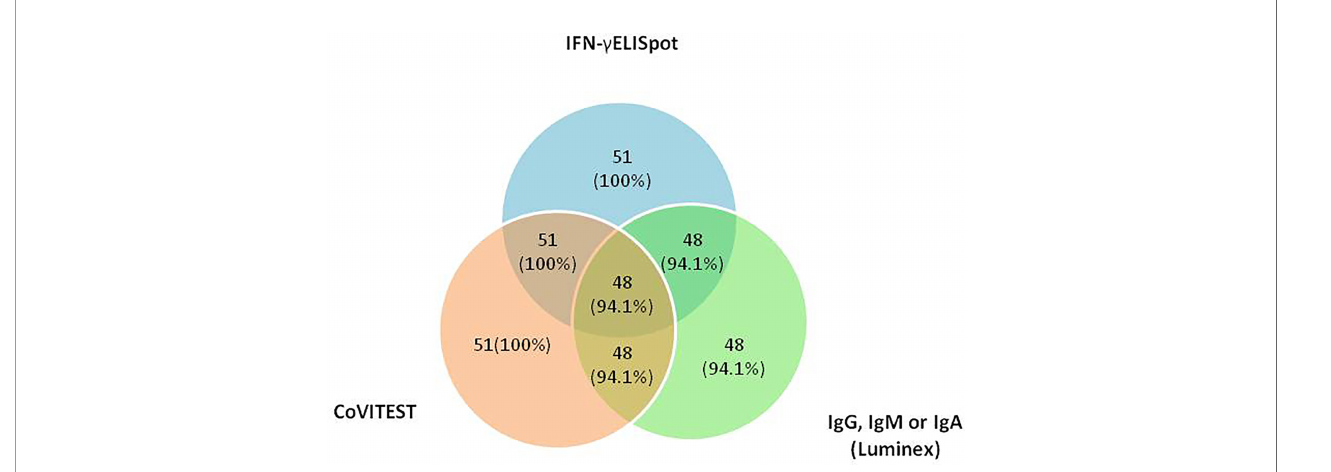
FIGURE 4 | Distribution of the cellular immune response to SARS-CoV-2 by IFN- g ELISpot, CoVITEST and antibodies against the Receptor Binding Domain (RBD) of the spike glycoprotein of SARS-CoV-2 (IgG, IgA or IgM) by Luminex in 51 COVID-19